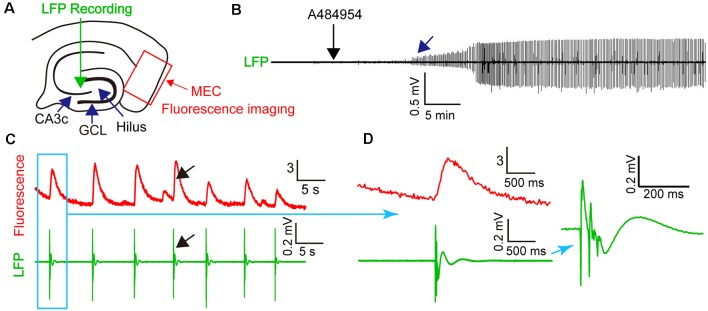
A484954-induced synchronicity of region-specific fluorescence transients in MEC correlated with local field potential (LFP) signals in the CA3 regions. (A) Schematic representation of an entorhinal–hippocampal slice with its subregions, LFP, and fluorescence recording positions. The overall fluorescence from identified neurons was analyzed. LFP and fluorescence time-lapse recording took place at the same time and slices. (B) A representative recording of LFP before and after drug application (black arrow) is shown. The onset of oscillation is indicated by a blue arrow. (C) Representative fluorescence (ΔF/F0) and LFP traces were depicted at the same time scale. A black arrow exemplifies temporally localized appearance of neuronal activity in both fluorescence and LFP channels. (D) Transients of fluorescence and LFP of the synchronized event in (C) are depicted for different temporal resolutions.